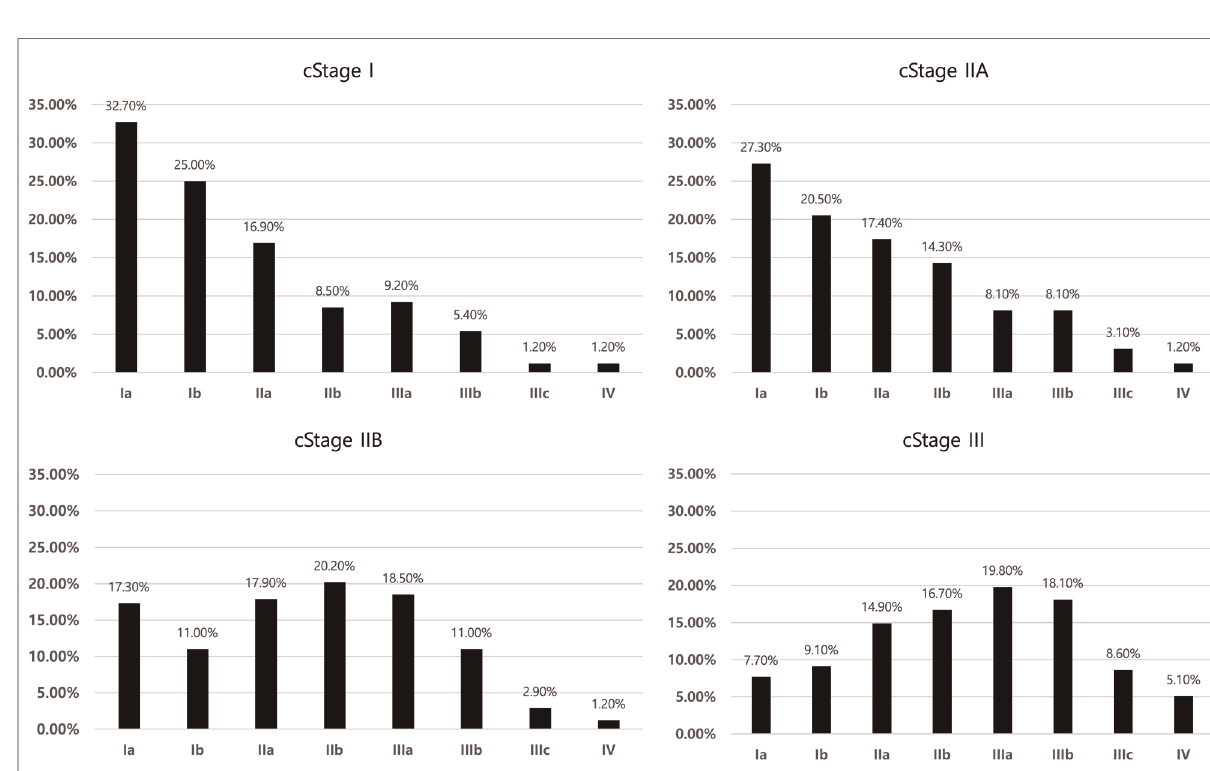
FIGURE 3 Distribution of pathologic staging among clinical stages according to 8th AJCC TNM staging